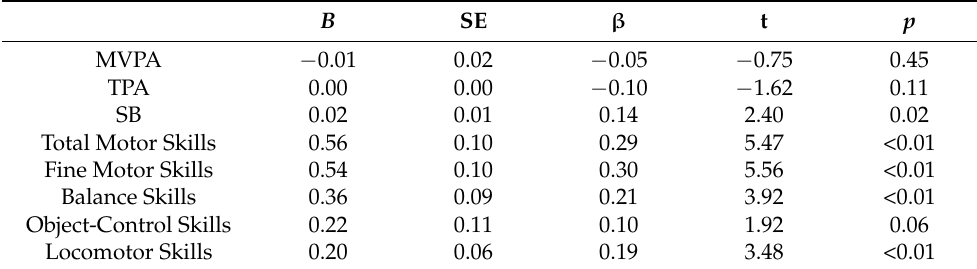
Table 6. Linear regression predicting school-readiness